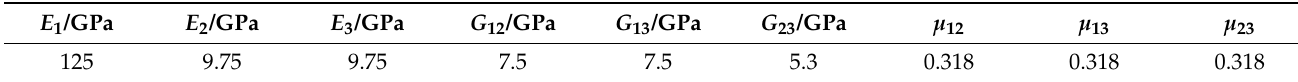
Table 2. Material properties of T300/epoxy resin